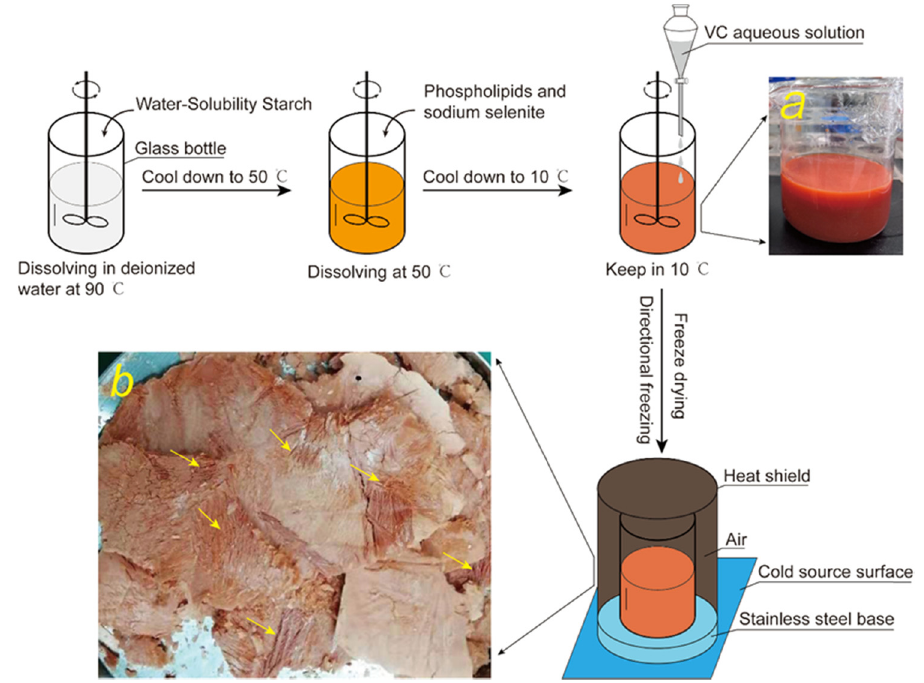
Figure 1: Synthesis of nano - selenium: ( a ) digital picture of synthesized solution sample and ( b ) digital picture of freeze - dried